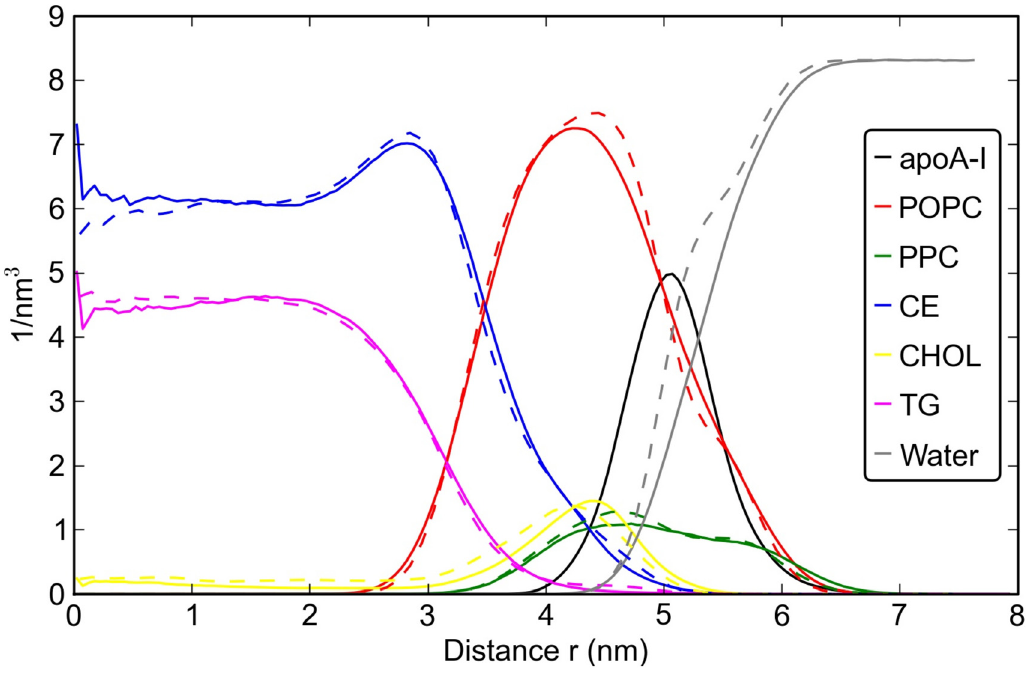
Figure 3. Radial densities showing the composition of the studied particles versus distance from the center of mass (COM) of the particle. The solid lines are for the full HDL particle, the dashed lines for the lipid droplet without apoA-I.